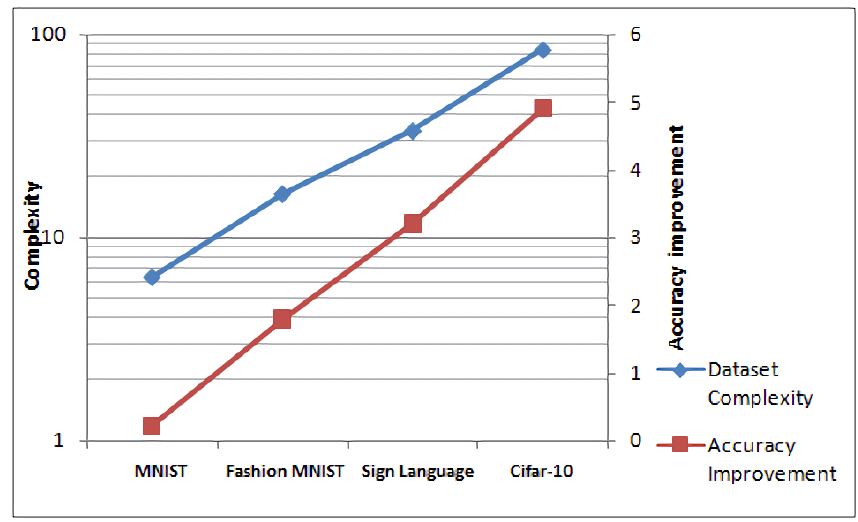
Figure 5. Correlation between the dataset’s complexity and accuracy improvement.